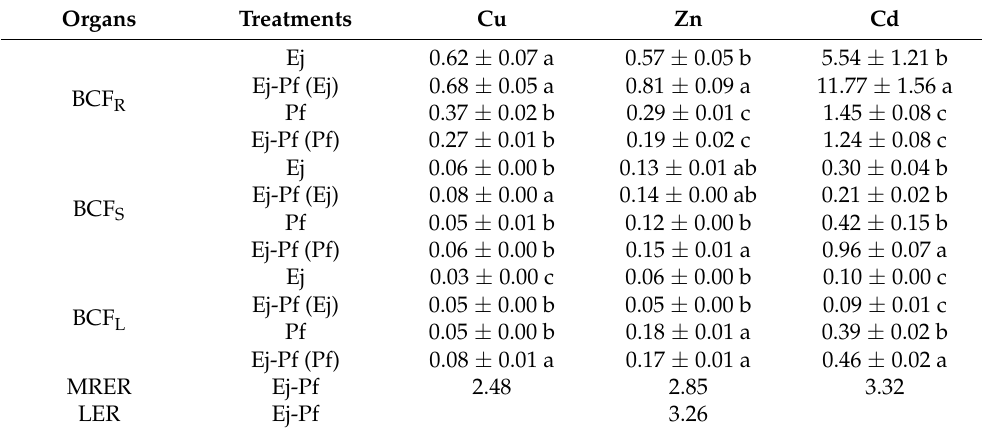
Table 2. The BCF, MRER, and LER of P. × fraseri and E. japonicus in different planting patterns. Organs